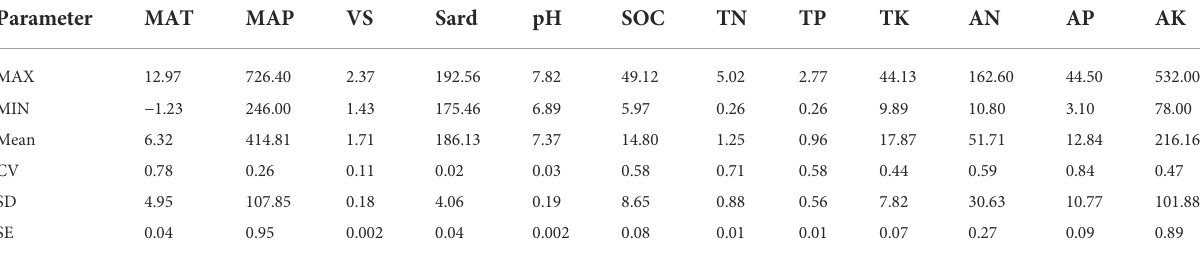
TABLE 2 Descriptive statistics of soil nutrient contents and environmental factors. Parameter